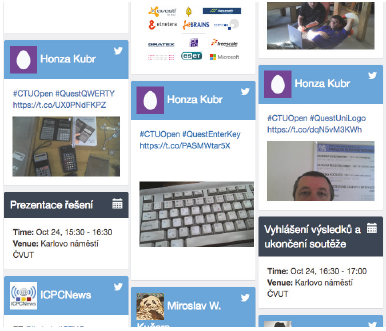
Figure 18: Kiosk content